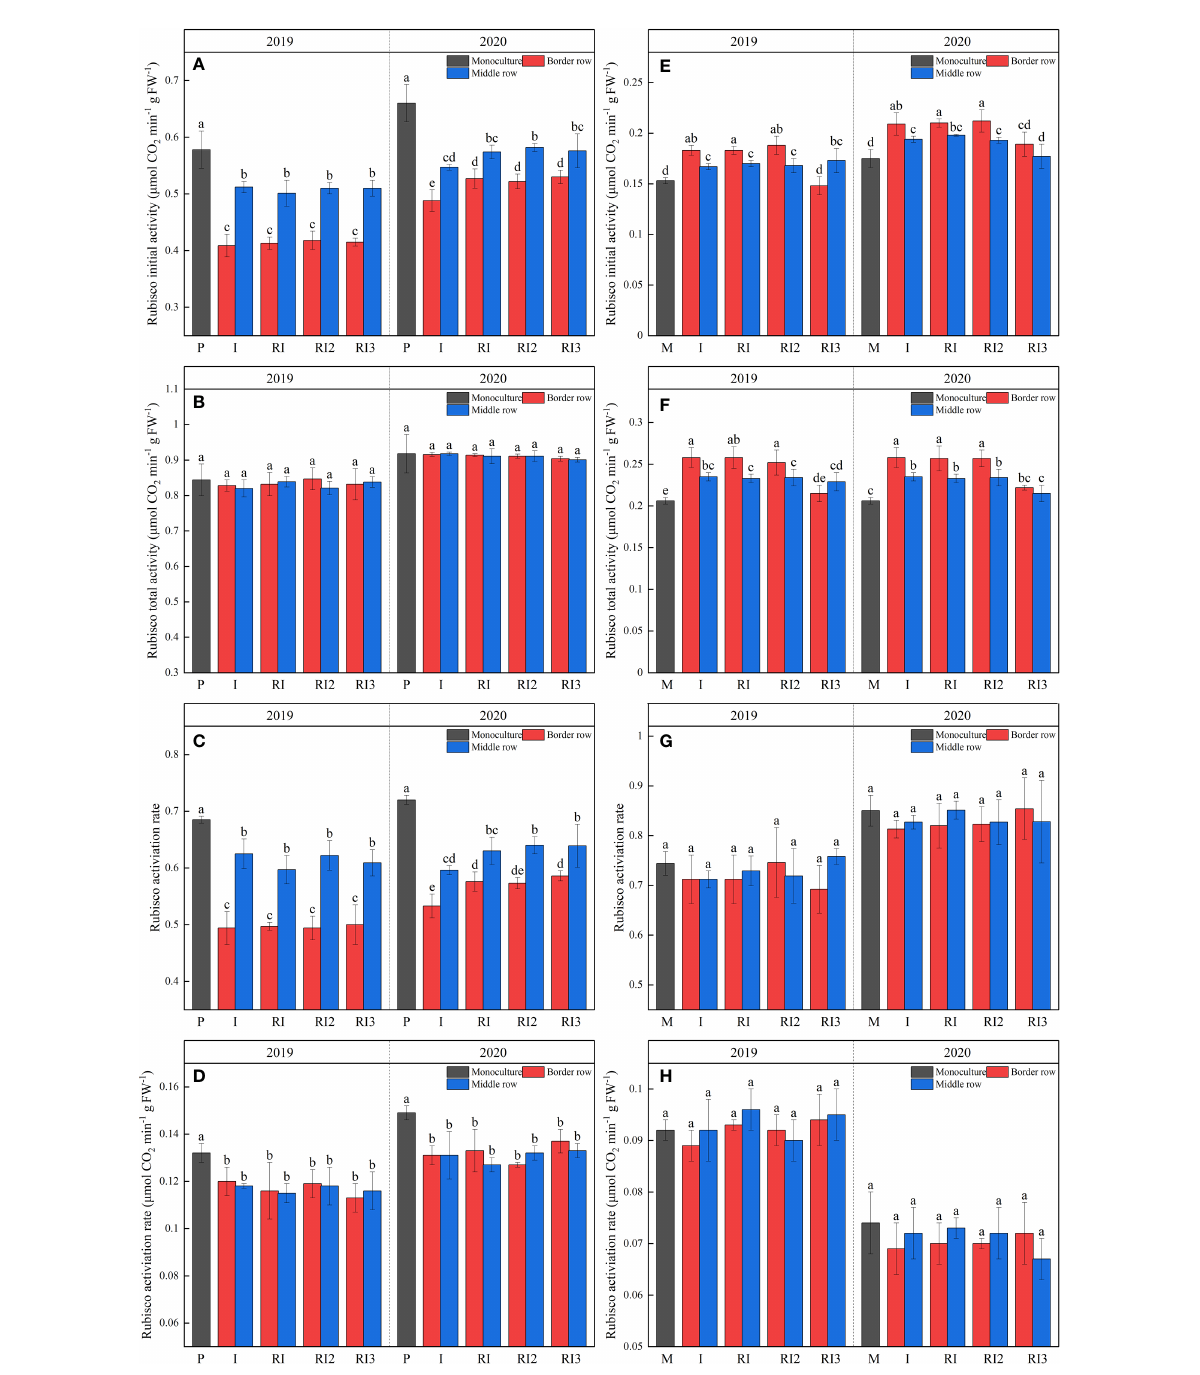
FIGURE 4 Rubisco initial activity (A, E) , Rubisco total activity (B, F) , Rubisco activation rate (C, G) , and Rubisco activase (D, H) of peanuts and maize. P, sole peanut; M, sole maize; I, maize – peanut intercropping; RI, maize – peanut rotation – intercropping, RI2, 20% N reduction for maize of RI; ICN3, 40% N reductions for maize of RI. Different lowercase letters represent signi fi cant